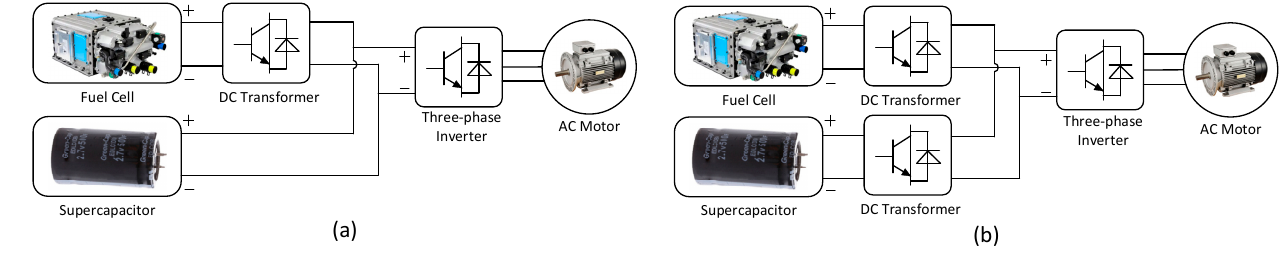
Figure 14. Topology of an FCEV (FC+SC). ( a ) Semi-active topology; ( b ) active topology.